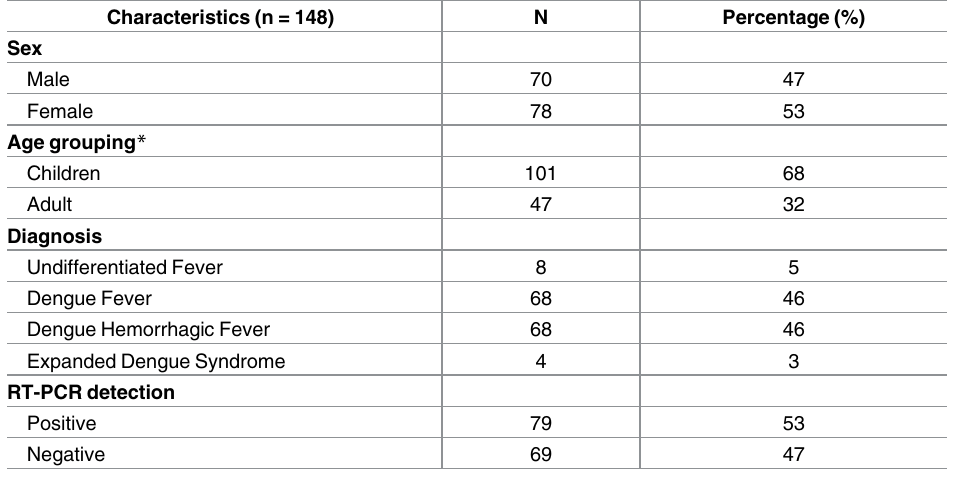
Table 1. Characteristics of dengue-suspected patients in